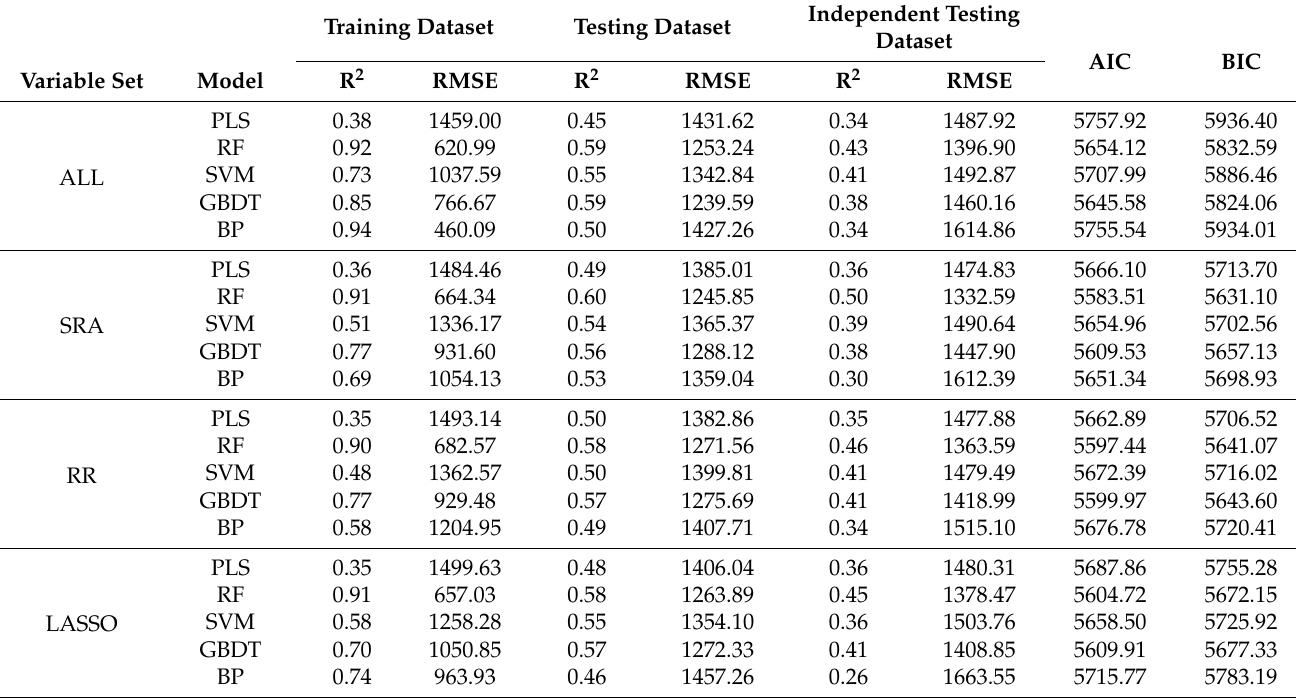
Table 3. Assessment of accuracy of the multi-factor grassland AGB estimation